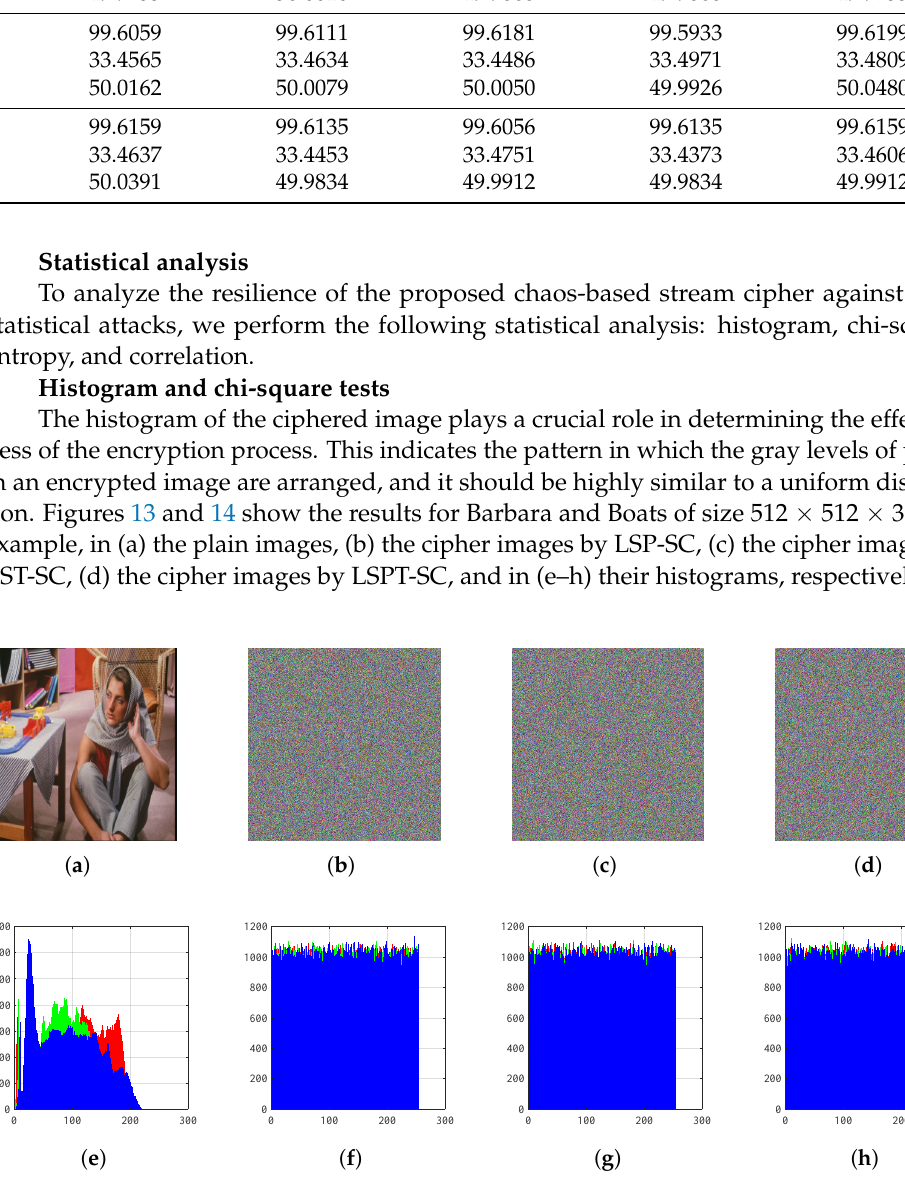
Figure 13. Results of Barbara image. ( a ) Plain image. ( b ) Encrypted image by LSP-SC. ( c ) Encrypted image by LST-SC. ( d ) Encrypted image by LSPT-SC. ( e ) Histogram of plain image. ( f ) Histogram of the ciphered image by LSP-SC. ( g ) Histogram of the ciphered image by LST-SC. ( h ) Histogram of the ciphered image by